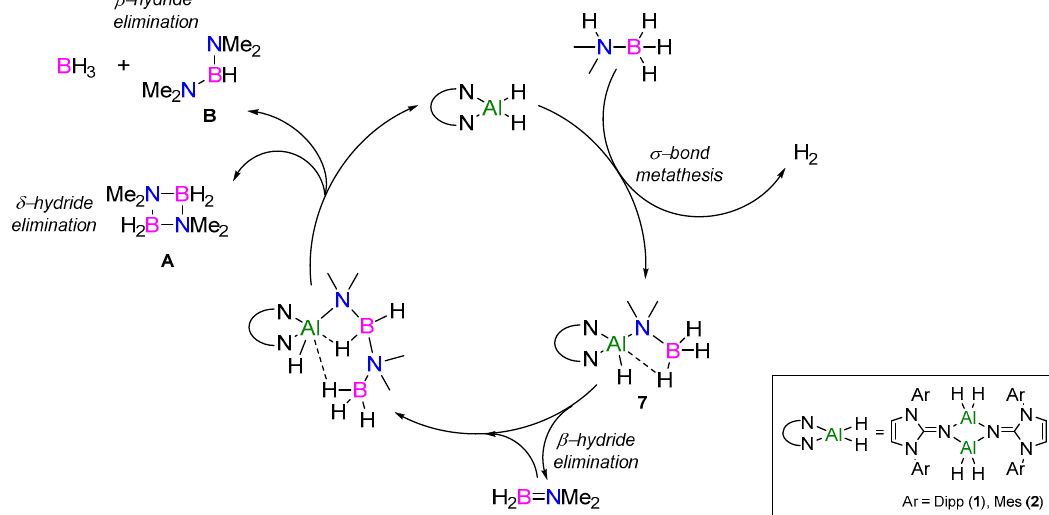
Figure 5. Proposed catalytic mechanism for the dehydrocoupling of Me 2 NHBH 3 with NHI ‐ supported Al(III) hydrides ( 1 , 2 ).